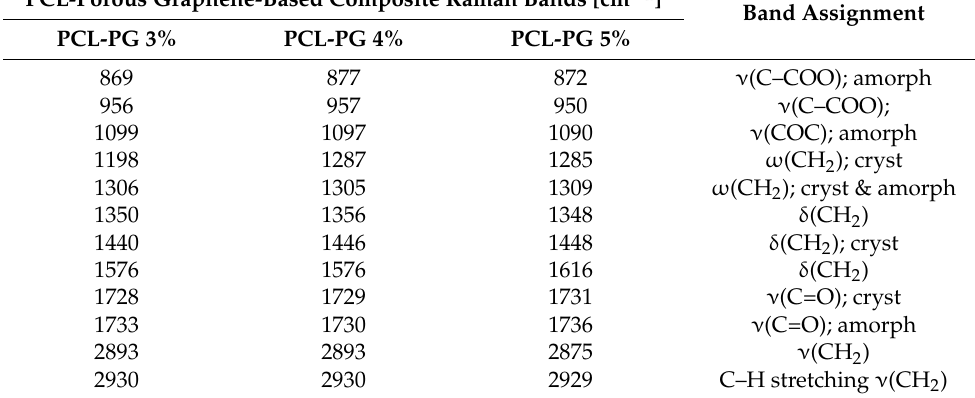
Figure 4. Raman spectra of 3, 4 and 5 wt% PG-PCL composite fibres. Table 2. Collected Raman bands (cm − 1 ) and their corresponding assignments for PCL-based graphene nanocomposite at 532 nm laser excitation [57–59]. PCL-Porous Graphene-Based Composite Raman Bands [cm − 1